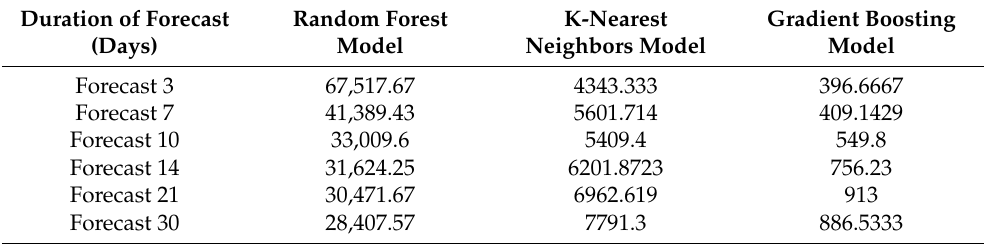
Table 8. Mean absolute error of forecasted cumulative new cases for Ukraine (number of